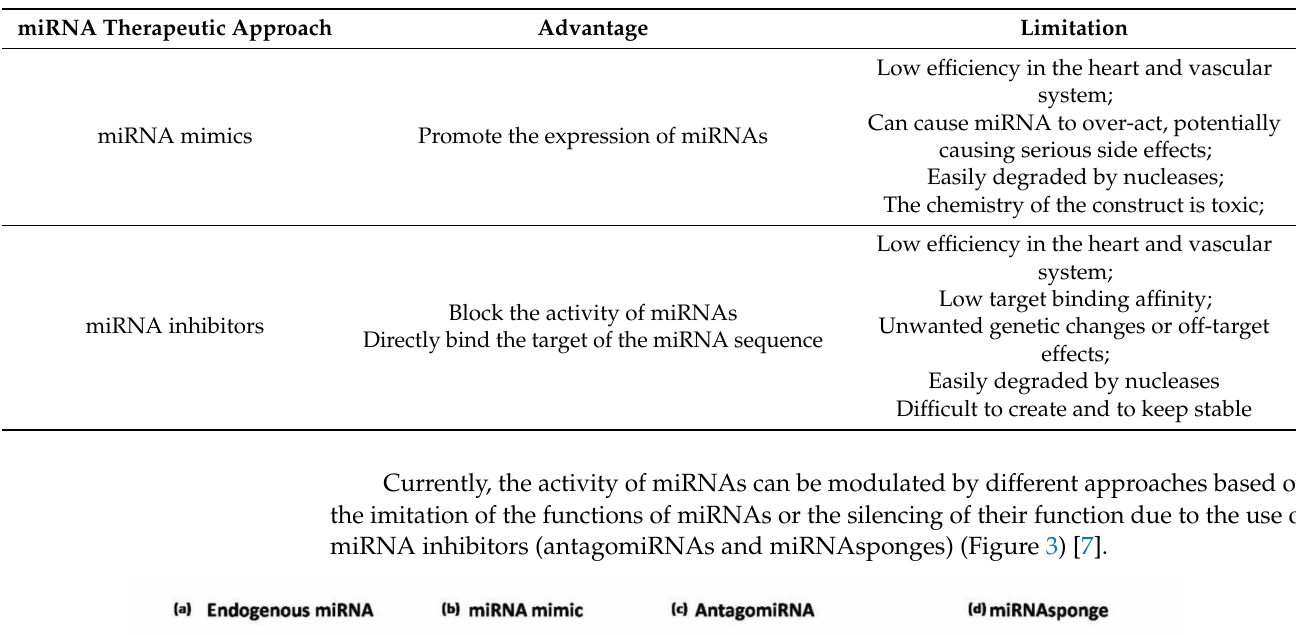
Table 3. The potential advantages and disadvantages of using miRNAs as an alternative therapy to conventional drugs.